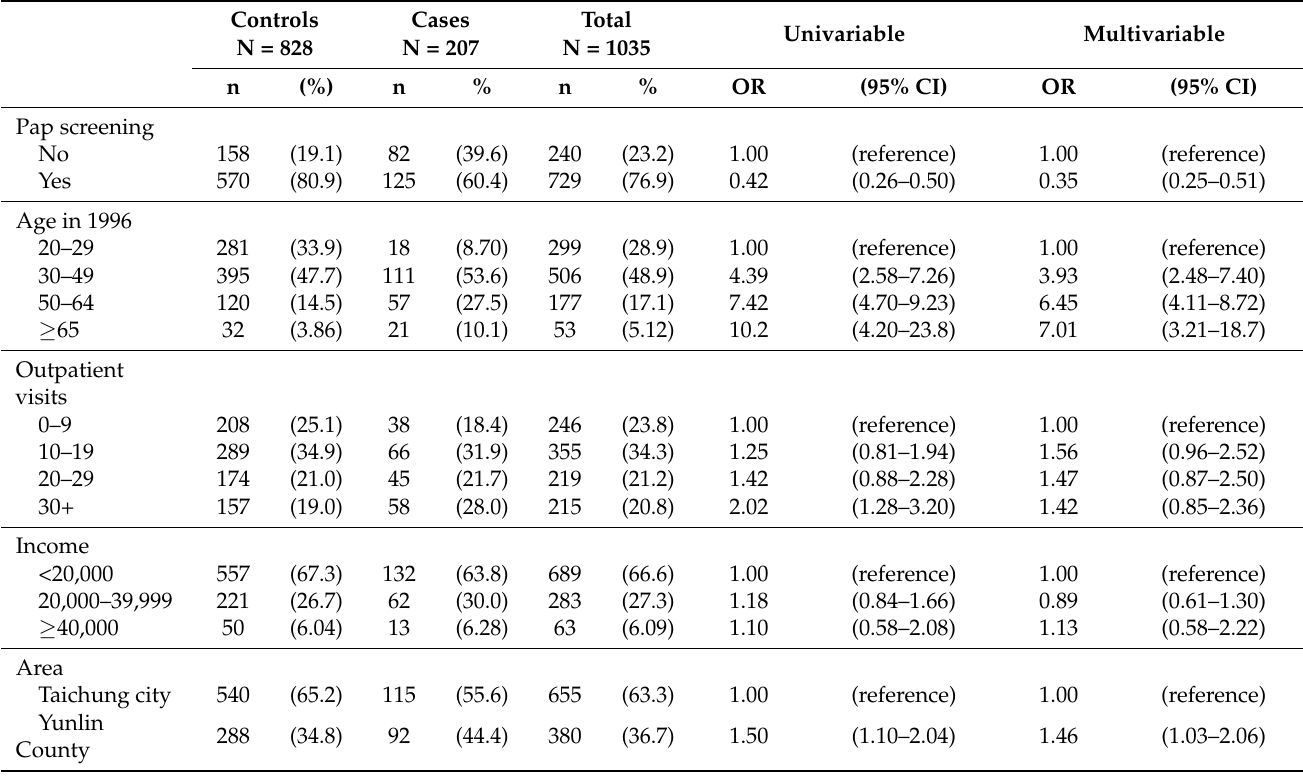
Table 3. Nested case-control analysis for measuring factors associated with diagnosed cervical cancer in women in Taichung city and Yunlin county